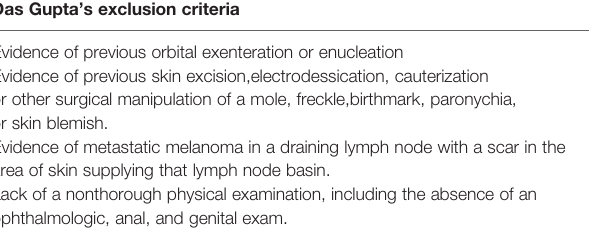
TABLE 1 | Das Gupta ’ s exclusion